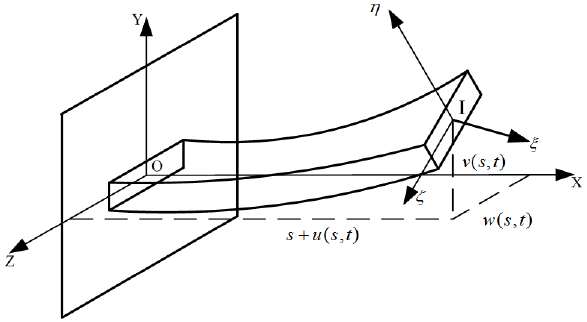
Figure 2. The cantilever beam.